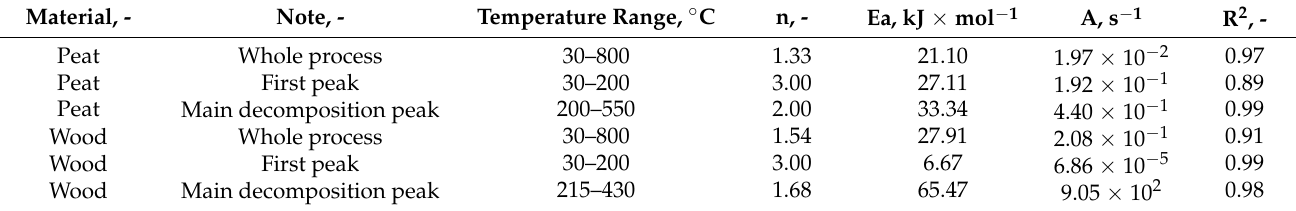
Table 2. Kinetic triplets determined at β = 10 ◦ C × min − 1 using the Coats–Redfern method. Material,